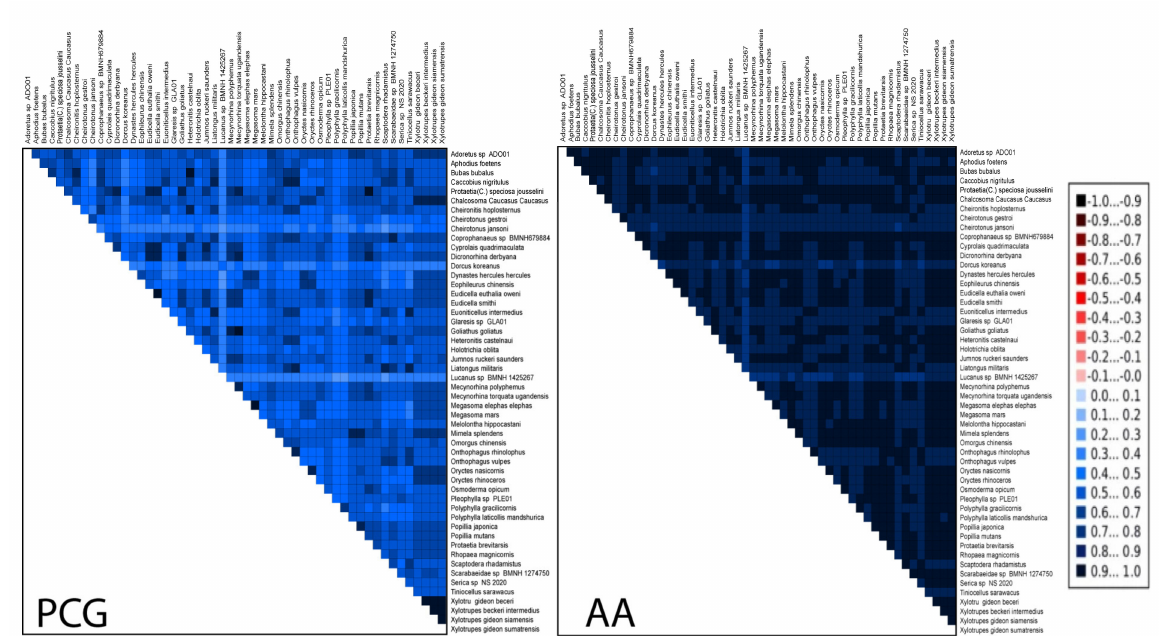
Figure 2. Heterogeneous sequence divergence within datasets of PCGs and AAs of all Scarabaeidae and outgroup species. The mean similarity score between sequences is represented by a colored square. AliGROOVE scores ranging from − 1 (indicating great difference in rates from the remainder of the dataset) to +1 (indicating rates match in all other comparisons). Red coloring shows significant